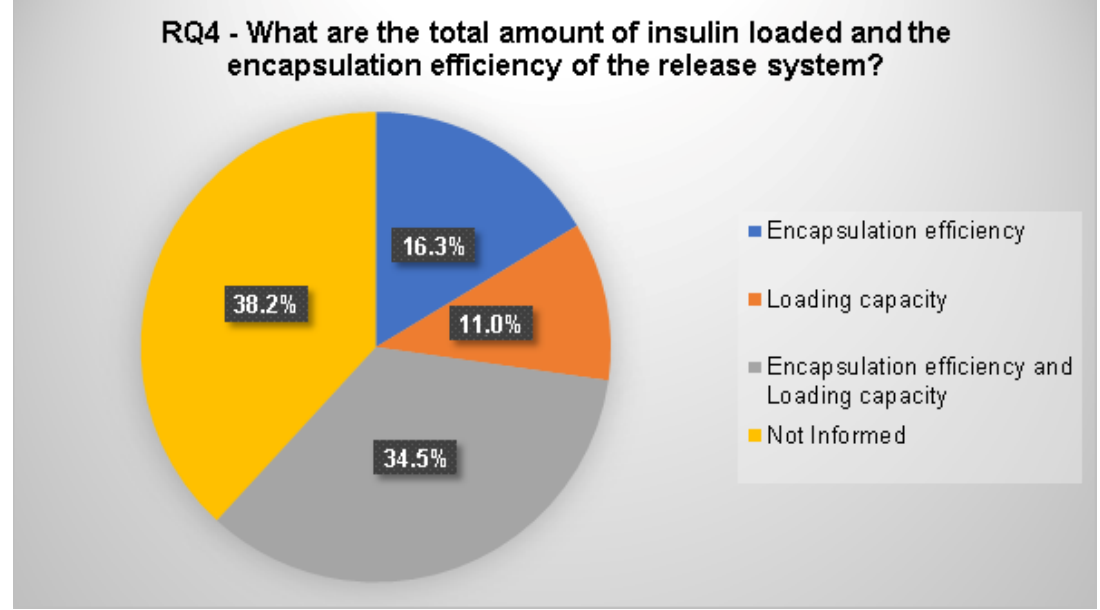
Figure 11. Classification of the articles according to the presence or absence of the release system load capacity and encapsulation efficiency analyses.